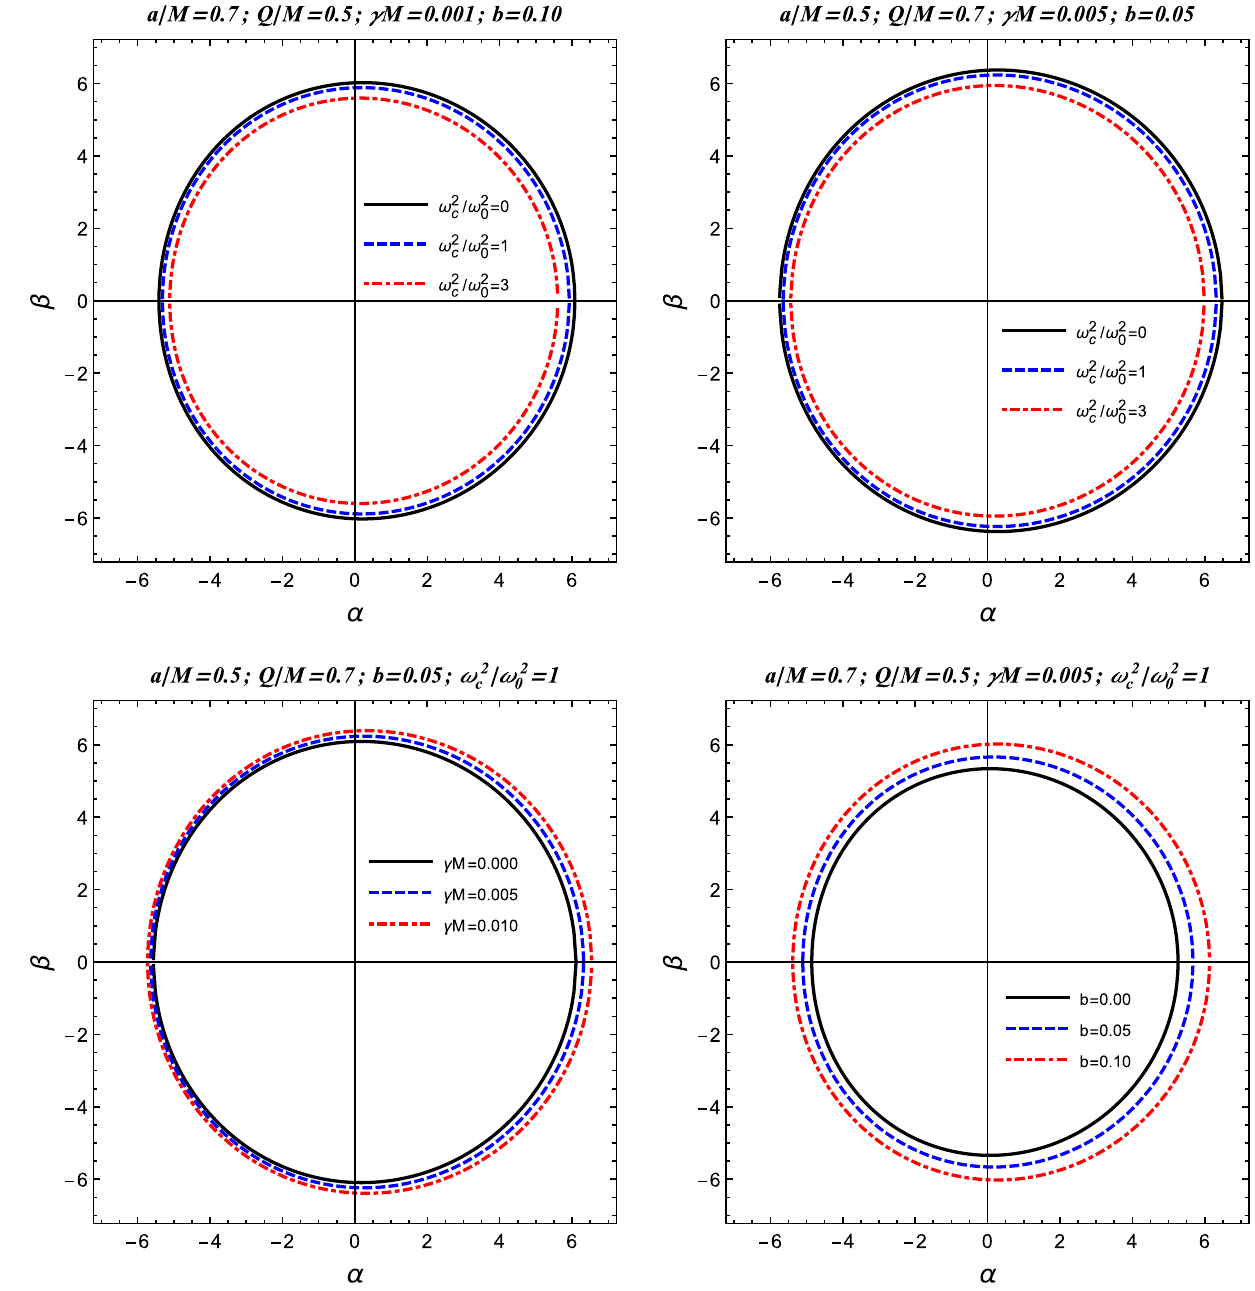
Fig. 7 Plots show the dependence of the black hole shadow in plasma on the different spacetime parameters